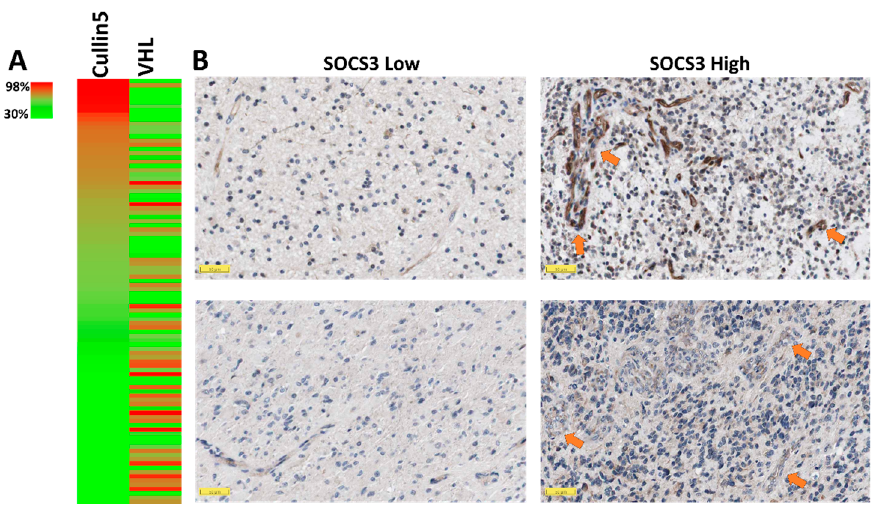
Figure 2. Clinicopathological study of SOCS3 protein in GBM. ( A ) Heatmap analysis of proteins cullin5 and VHL in GBM. ( B ) Immunohistochemistry staining for SOCS3 in 4 GBM cases. Arrows indicate blood vessels. Image credit: Human Protein Atlas. Scale bar: 50 μ M.